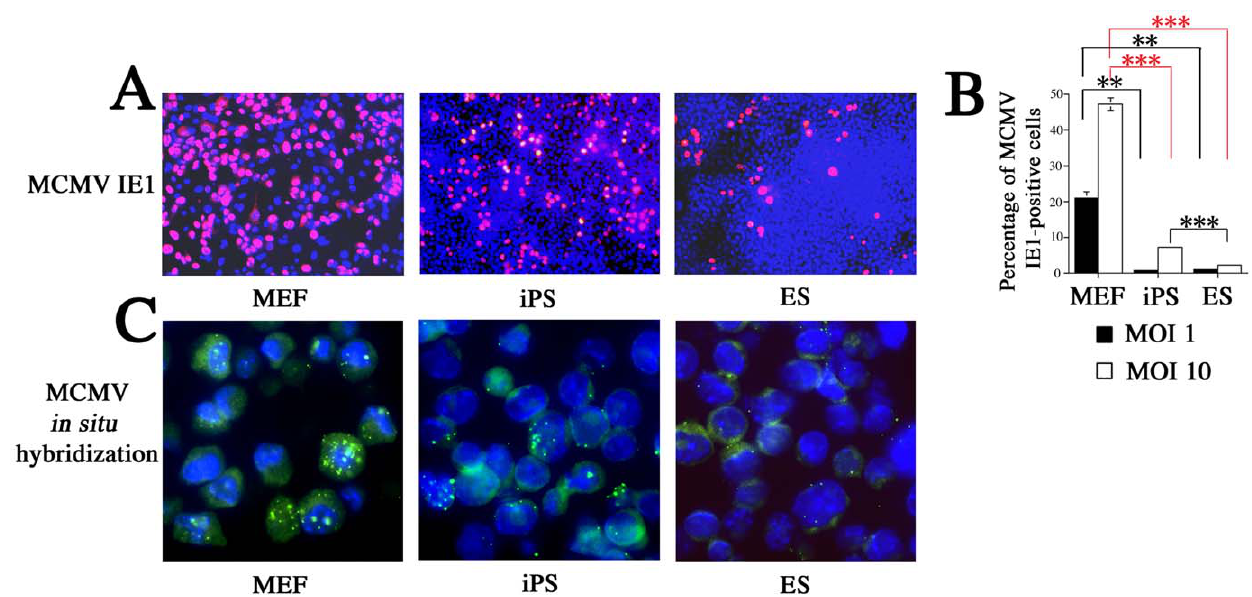
Figure 9. Comparison of MCMV resistance in MEF, iPS, and ES cells. (A) Results from immunocytochemical analyses visualizing MCMV IE1- positive cells (red) in the 3 cell cultures after infection with MCMV at an MOI of 10. (B) Flow cytometry was used to confirm that iPS and ES both had lower numbers of IE1-positive cells than MEF, when infected at MOIs of 1 ( P , 0.01) and 10 ( P , 0.001). At an MOI of 10, iPS cells showed higher expression than ES cells of IE1 (7.27% vs. 2.17%) ( P , 0.001). (C) Results from in situ hybridization showing that MCMV signaling in all 3 cultures was proportional to the amount of IE1-positive cell expression. All presented experiments were performed at least 3 times, and data are given as the mean 6 SD. ** P , 0.01, *** P , 0.001, t- test.